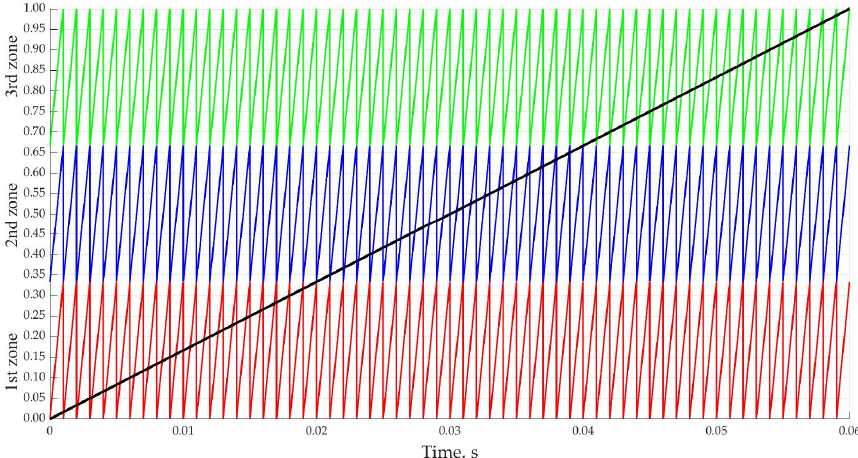
Figure 6. Oscillograms of modulating and reference signals in dynamics.